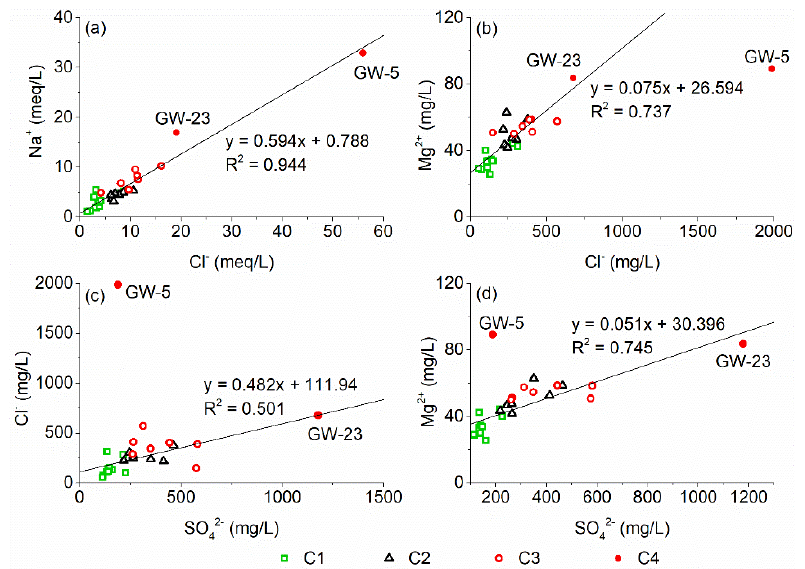
Figure 7. The relationship between the concentrations of Na + , Mg 2+ , Cl − , SO 42 − in groundwater in the study area.